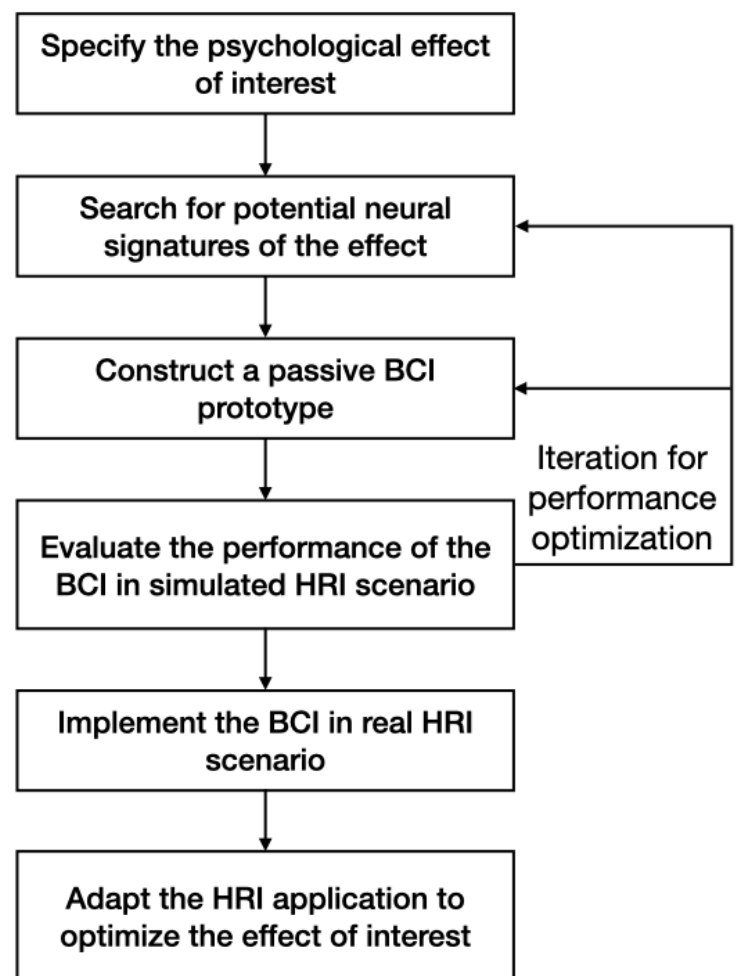
Figure 2. General steps for developing BCIs for HRI evaluation and optimization.